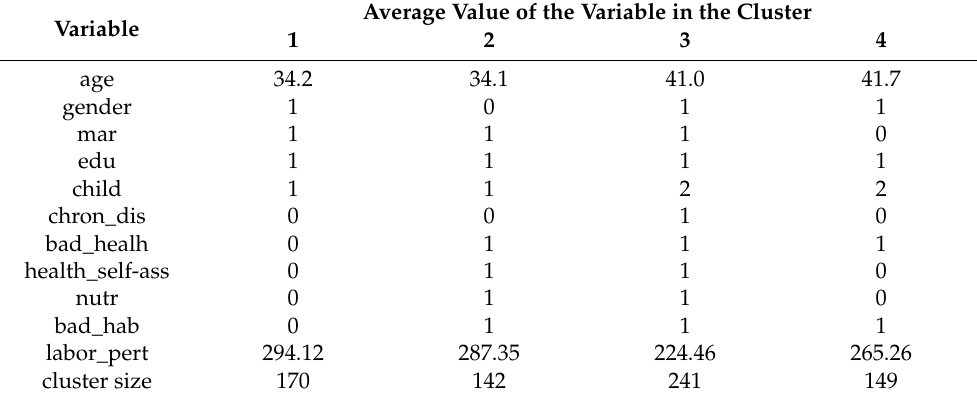
Table 6. Clusters’ centers